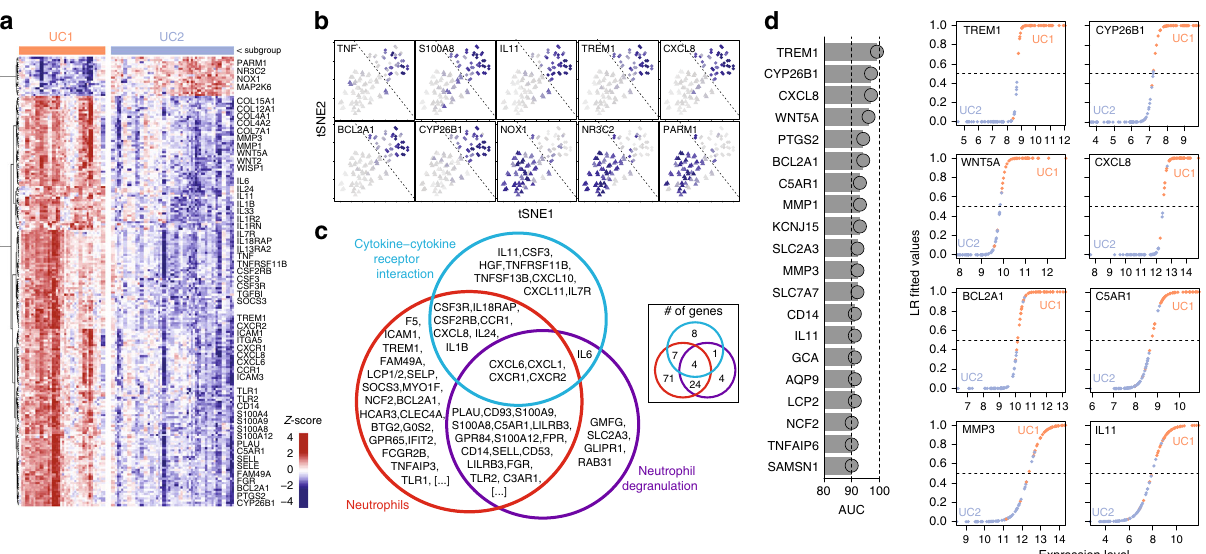
Fig. 4 UC1 transcriptomic pro fi le is enriched for the in fl ammatory signature. a Heatmap of DEGs between UC1 and UC2 patients, including all genes in the human data set. Only the selected genes are shown, grouped by functional categories and respective to the expression level. b t-SNE overlay of the expression level of selected DEGs between UC1 and UC2, showing inter-patient variation. c Venn diagram of the top GO, KEGG, and cell-enriched terms identi fi ed from the DEGs between UC1 and UC2. d Top 20 genes ranked by area under the curve (AUC) for speci fi city and sensitivity to distinguish UC1 from UC2, among the list of DEGs (left). Classi fi cation was carried out using logistic regression. The fi tted values of prediction are shown for selected genes